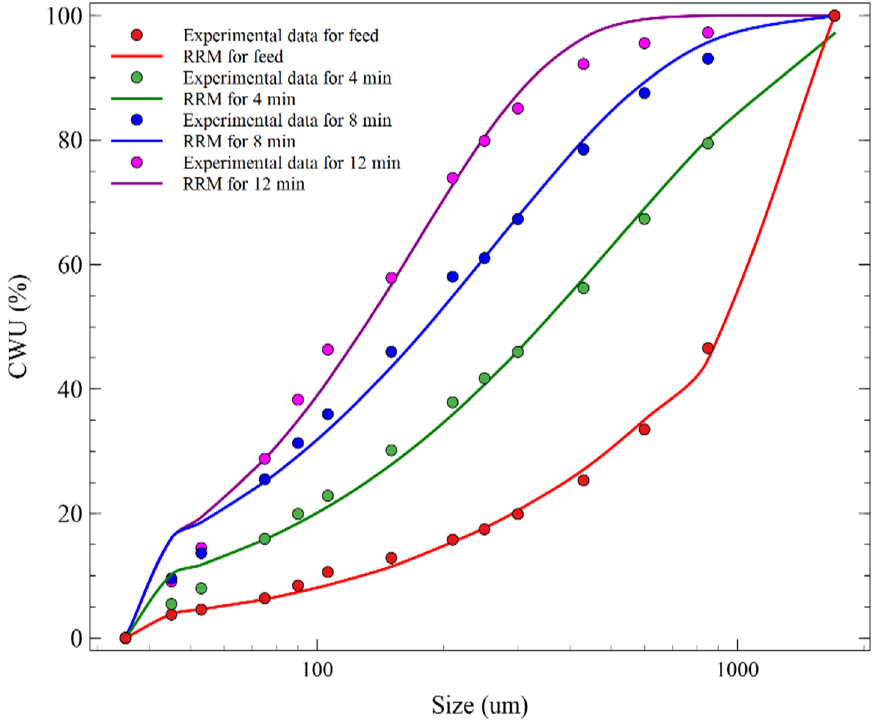
Figure 3. Semi-log plot of PSD and PSDM for feed minerals and different grinding time. With the respective trends obtained in Figure 3, it was possible to determine the PSCP Table 1. PSCP of the feed and under different grinding times. of the feed and the grinding product, as presented in Table